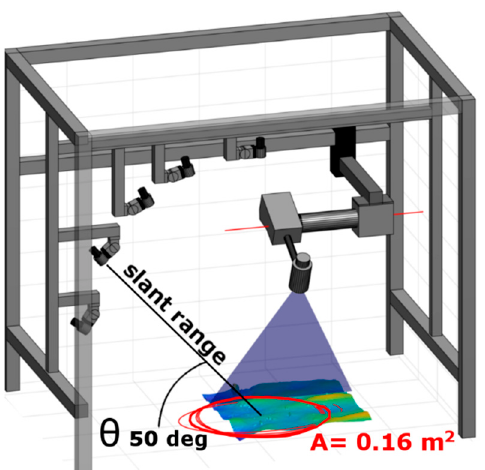
Figure 2. Setup of the lander frame. The size of the lander frame is 120 cm × 80 cm × 100 cm. Displayed are the slant range and the grazing angle θ of the selected profiler, which is defined as the angle between the wavefield motion and the zero mean seafloor surface. The red circles mark the areas of the acoustic footprint. In blue the laser swath is highlighted. The ULS200 mid-range laser scan system is manufactured by 2G Robotics, and the acoustic transducer units by Benthowave Instruments Inc.